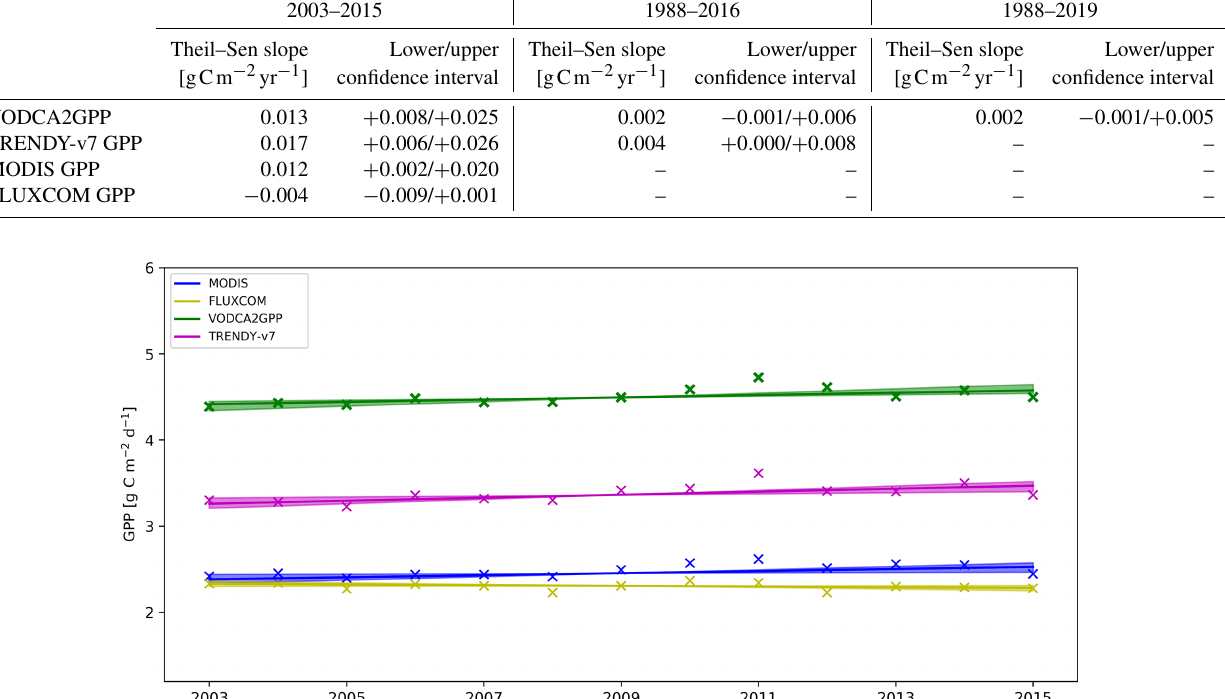
Figure 7. Time series of yearly median GPP with the regression lines as obtained by the Theil–Sen estimator. Areas around the regression lines indicate the 90% confidence